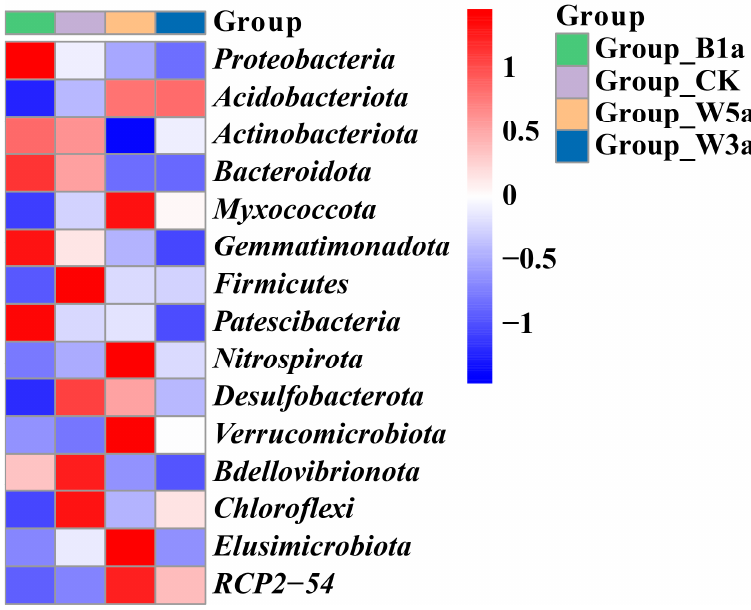
Figure 1. The composition of bacterial communities at the phylum level in the casing soil of different treatments of G. leucocontextum cultivation .